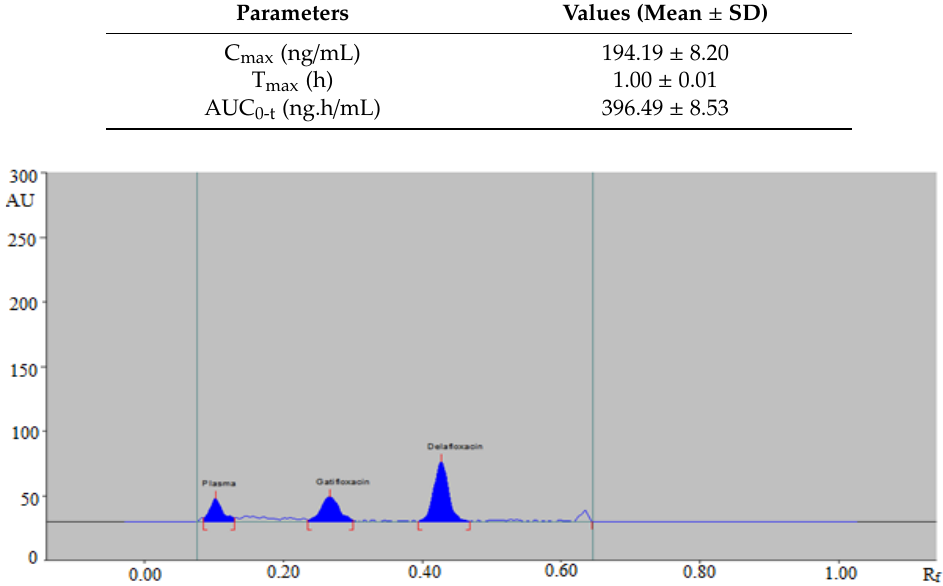
Figure 4. HPTLC densitogram of rat plasma obtained 1 h after oral administration of DLX in the presence of IS (150 ng/band). Antibiotics 2020 , 9 , x